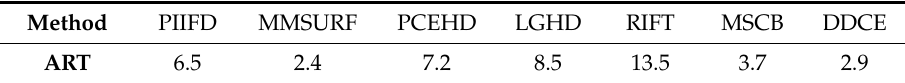
Table 8. Average running time.